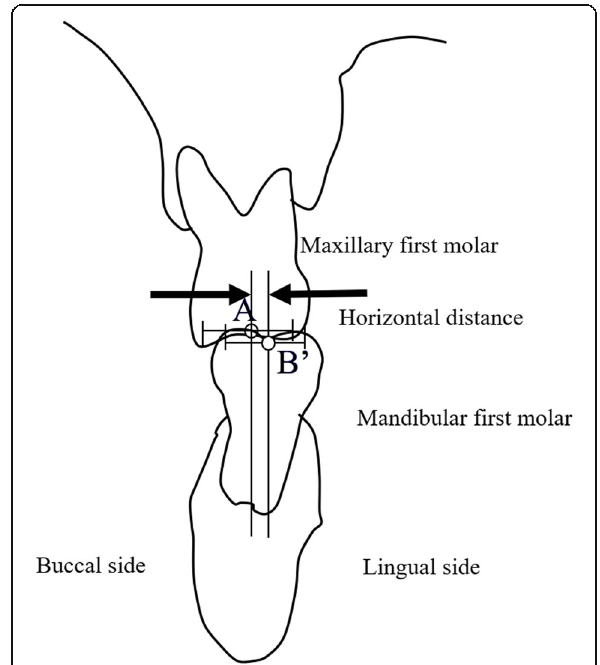
Fig. 2 Cross-sectional image perpendicular to the dental arch passing through the mesiodistal midpoint of the maxillary first molar: a natural mandibular first molar. A: reference point of the maxillary first molar. B ’ : reference point of the mandibular first molar: buccolingual midpoint of the occlusal surface of the mandibular first